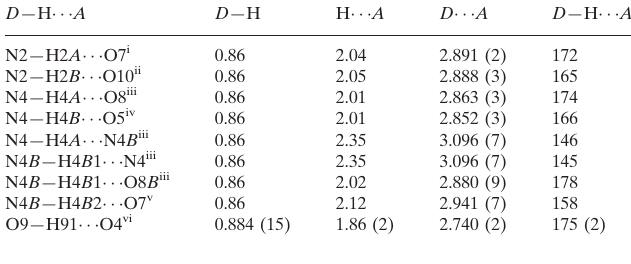
Hydrogen-bond geometry (A˚ , (cid:3)